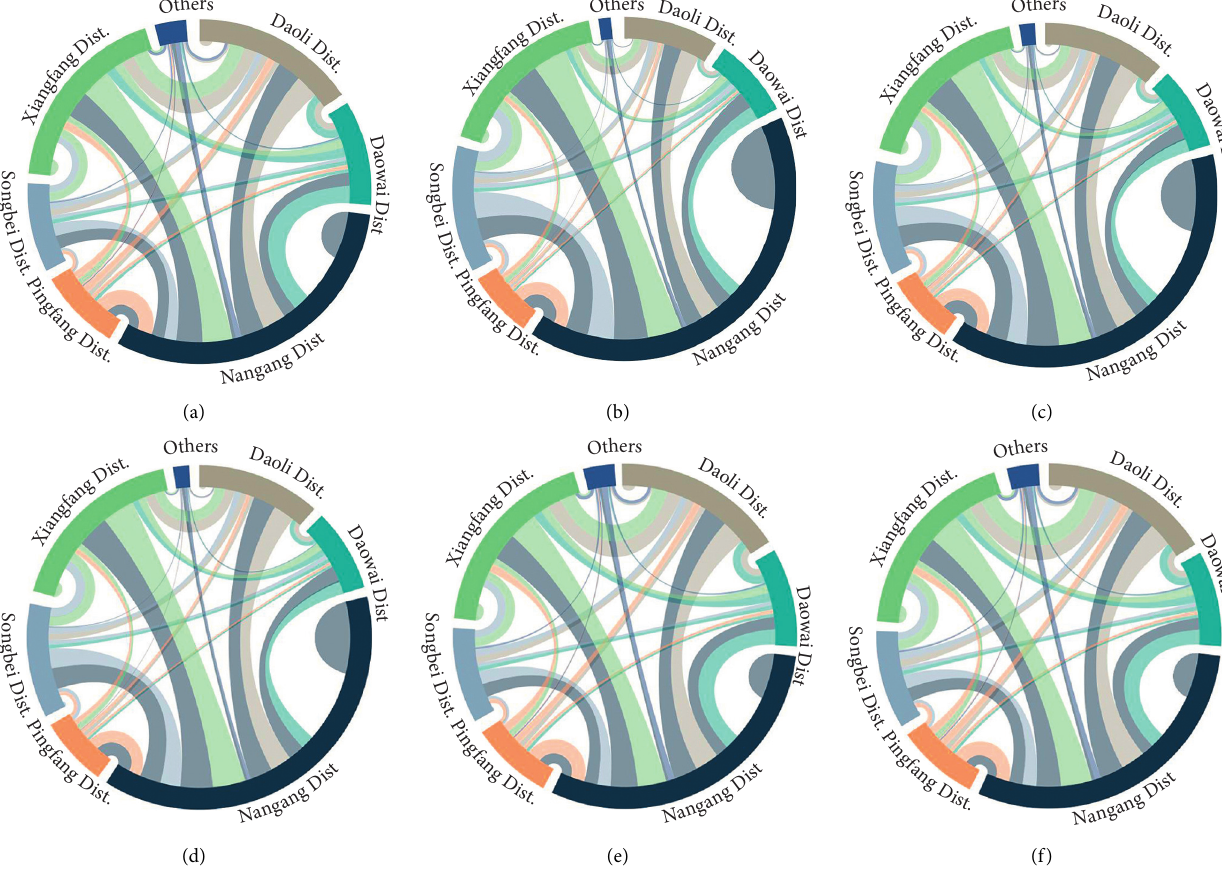
Figure 10: OD flows in different districts of Harbin over 6 days. (a) December 9th. (b) December 10th. (c) December 11th. (d)